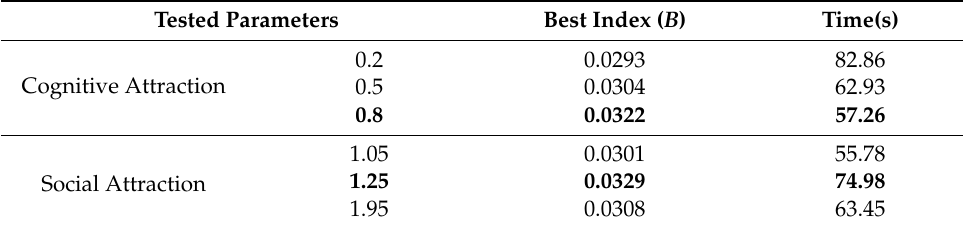
Table 2. Summary of trimming tests for